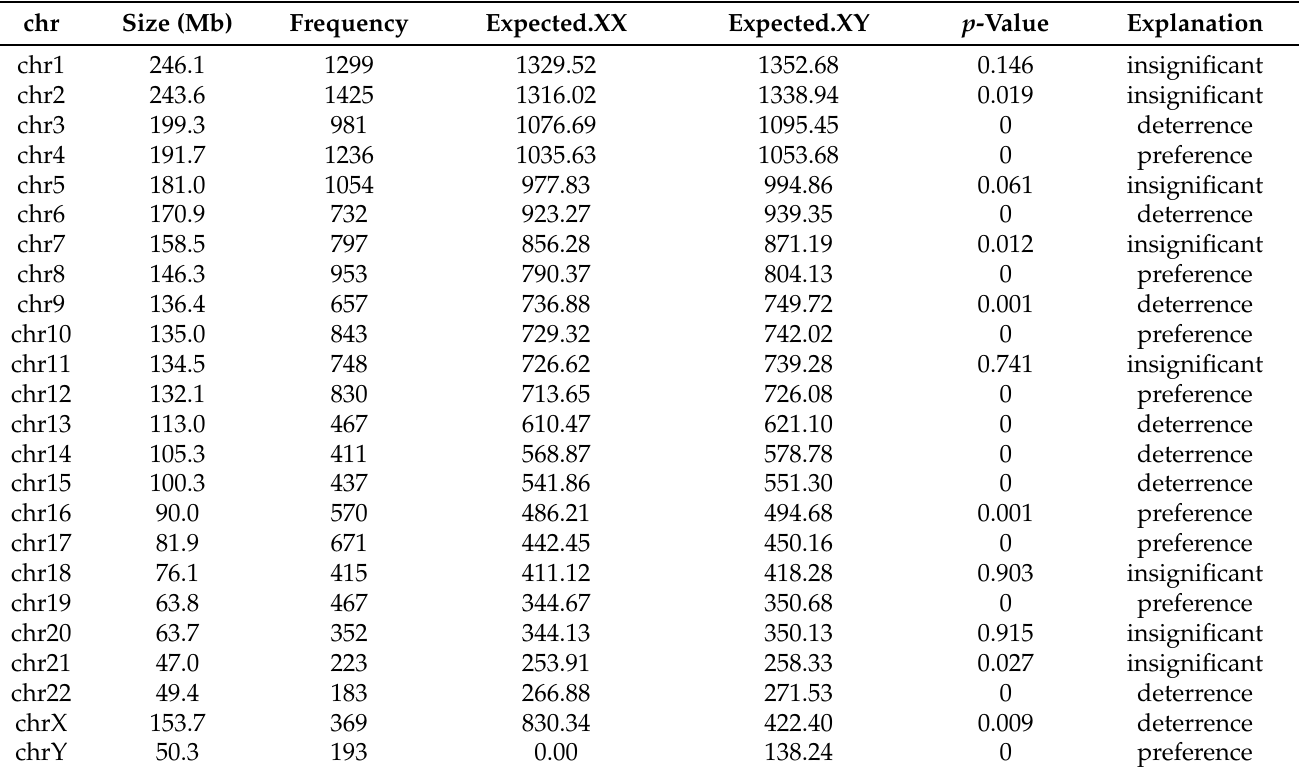
Table 1. Chromosomal location of HBV integrations and evaluation of possible preference or de- terrence to specific chromosomes by binomial tests ( p < 0.01), assuming that HBV integration is a random event and that the genomic loci of the integration depend on the size of each